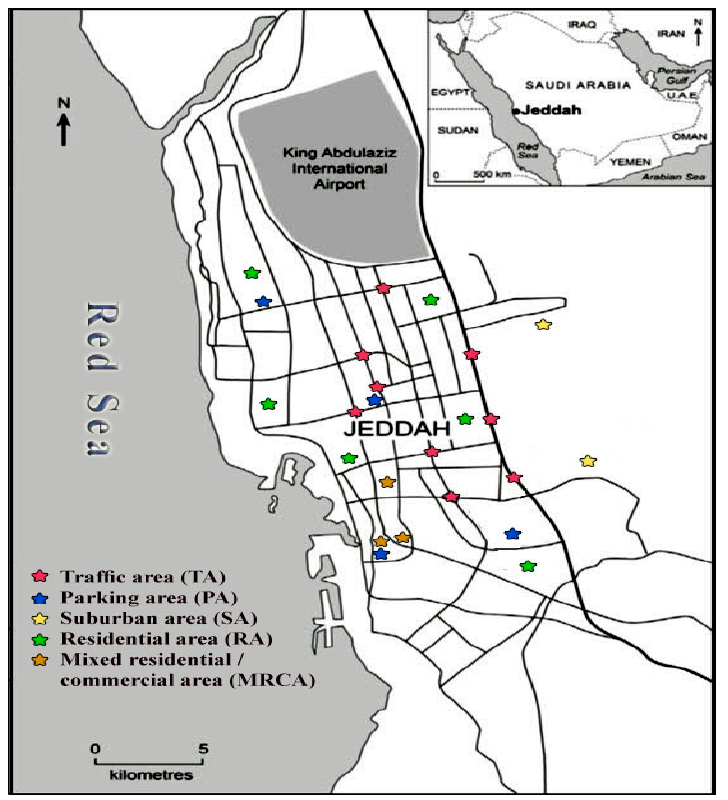
Figure 1. Sampling site distribution in the different functional areas of Jeddah.